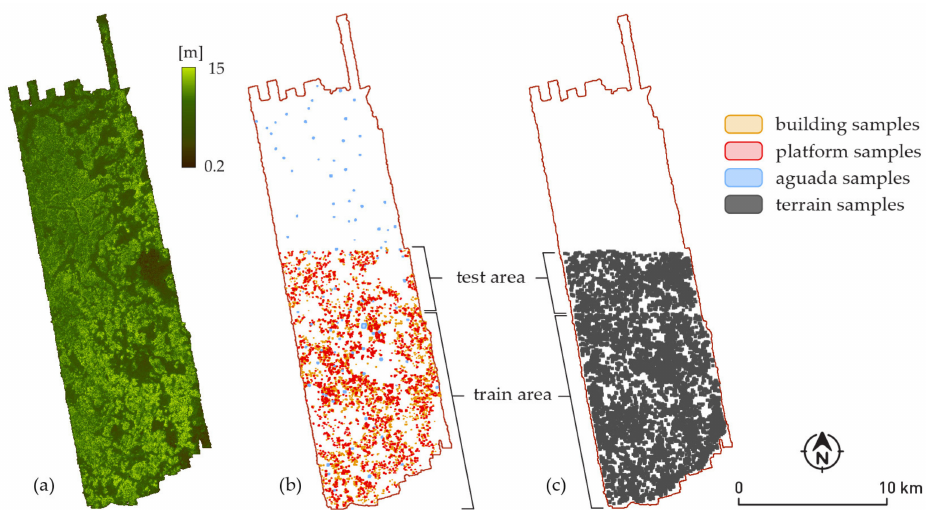
Figure 2. The study area is covered by a natural, unmanaged forest and bushes, whose heights rarely exceed 20 m ( a ). Annotated buildings and platforms are concentrated in the lower part of the study area, while aguadas have been annotated throughout it ( b ). Terrain samples are shown in ( c ). Samples of all four classes were separated into the training set and the test set, according to their geographical locations. Each individual sample was placed in the train set if it was located entirely within the boundaries of the training area, or placed in the test set if it was located entirely within the boundaries of the test